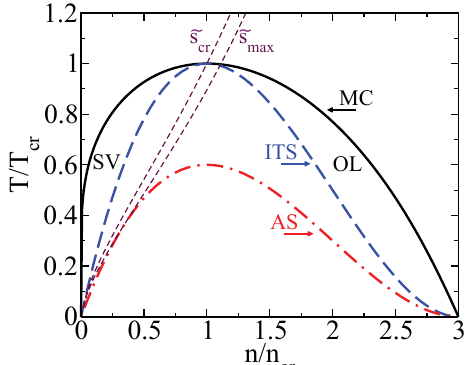
Figure 2. The phase diagram of the van der Waals equation of state on the T ( n ) -plane. The bold solid, dashed, and dash-dotted curves show the boundaries of the MC, the spinodal region at T = const, and ˜ s = const, respectively. The short dashed lines show two adiabatic trajectories of the system evolution: the curve labeled (cid:101) s cr passes through the critical point; (cid:101) s max passes through the maximum pressure point P ( n P , max ) on the P ( n ) plane, cf.